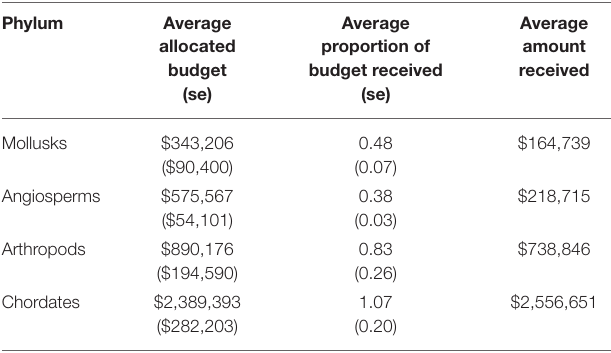
TABLE 1 | Average allocated budget and proportion of budget received for each of the four phyla (se = standard